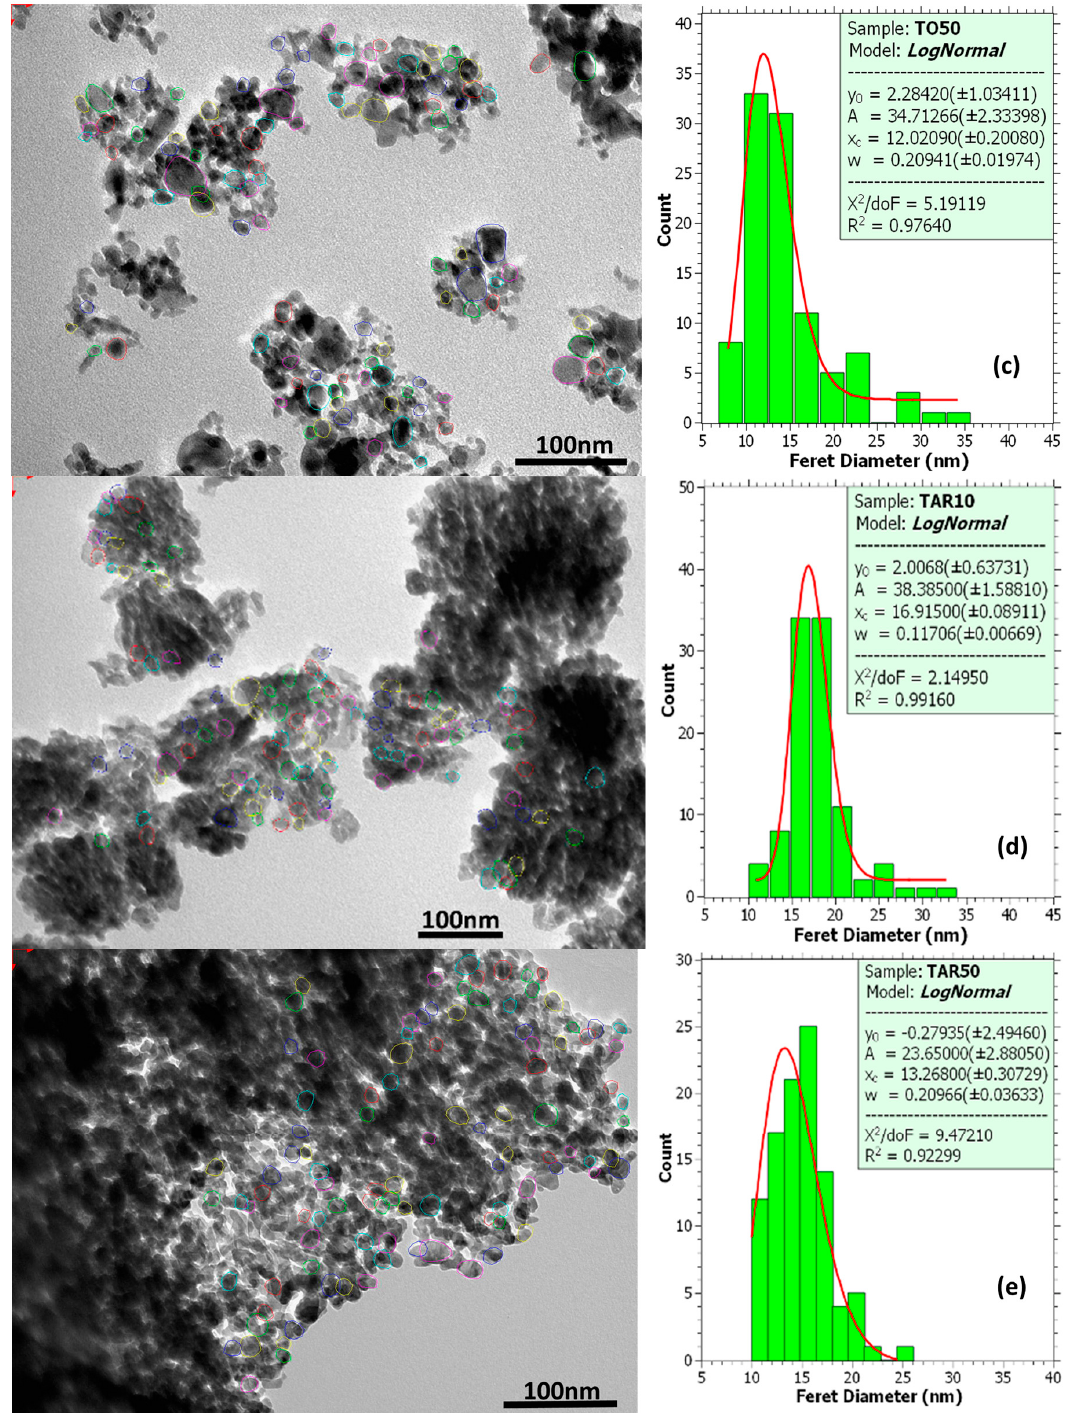
Figure 4. TEM image, selected area electron diffraction (SAED) pattern and distribution of grain size for the mesoporous TiO 2 film ( a ), and the buffer layers: TO10 ( b ), TO50 ( c ), TAR10 ( d ) and TAR50 ( e ).